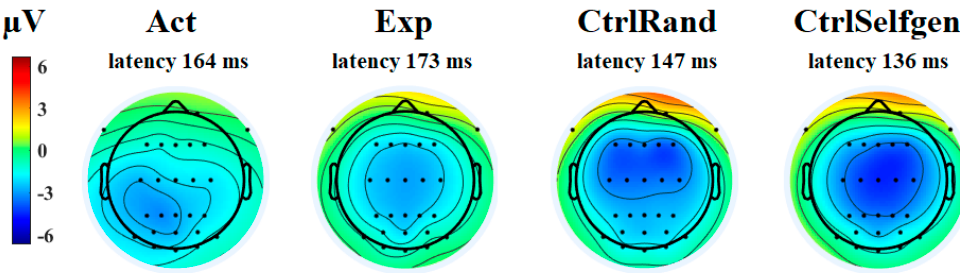
Figure 5. Topographical maps of grand average auditory N1 amplitude for different conditions at its peak latency in the grand average ERP.